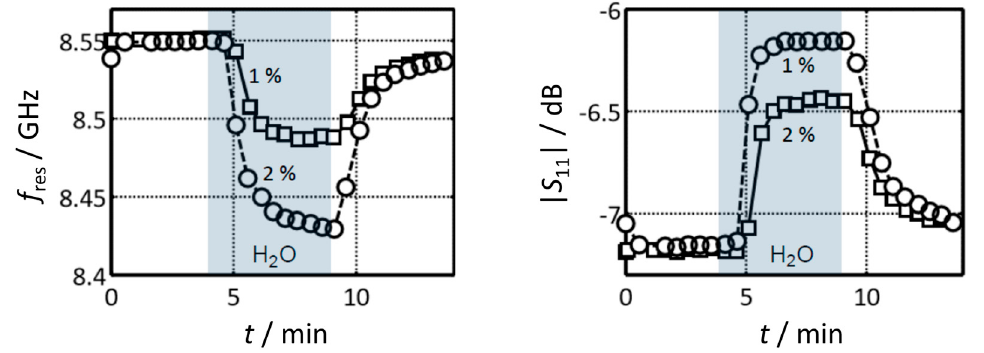
Figure 4. Resonant frequency ( left ) and reflection parameter at resonant frequency ( right ) when exposed to nitrogen and water (1 vol. % and 2 vol. %) in